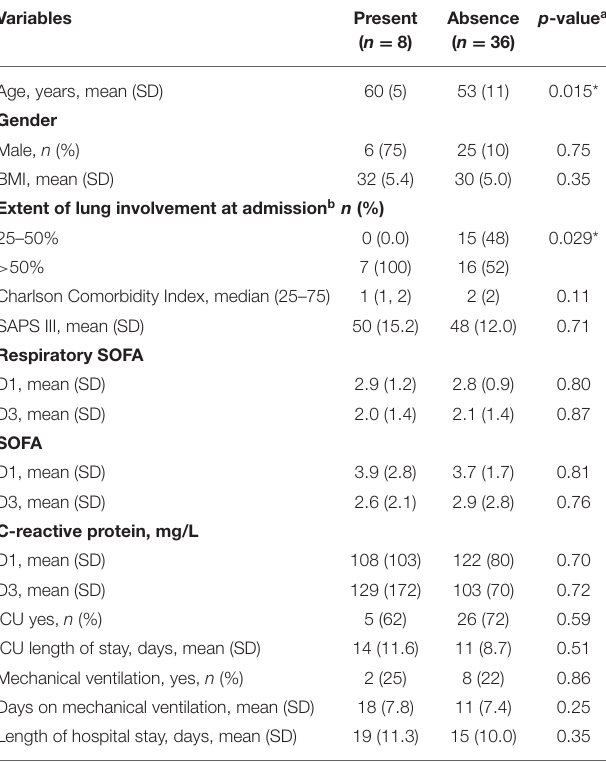
TABLE 5 | Variables associated with a decreased carbon monoxide diffusion 6-months after hospital discharge. Variables ( n = 8)